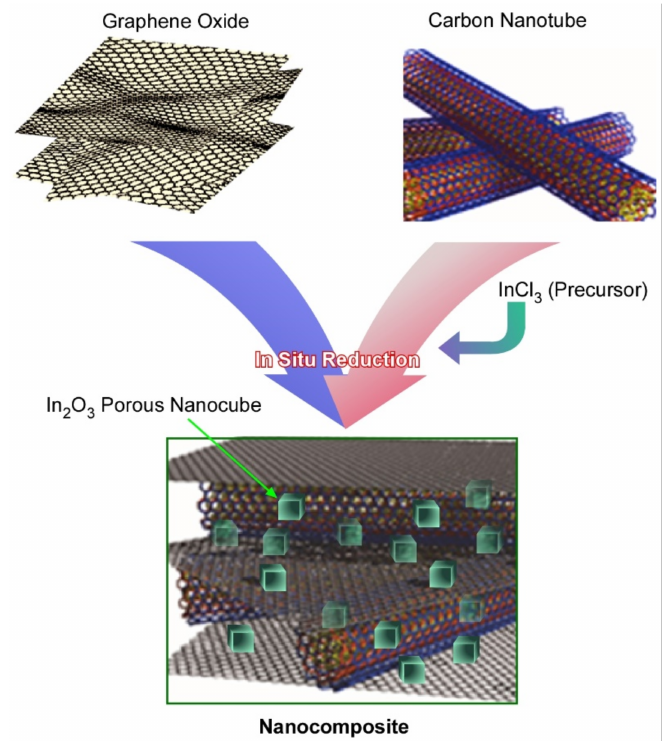
Figure 10. Fabrication of ternary nanocomposite material composed of mesoporous Indium oxide (In 2 O 3 ) nanocubes embedded into carbon nanotubes and reduced graphene